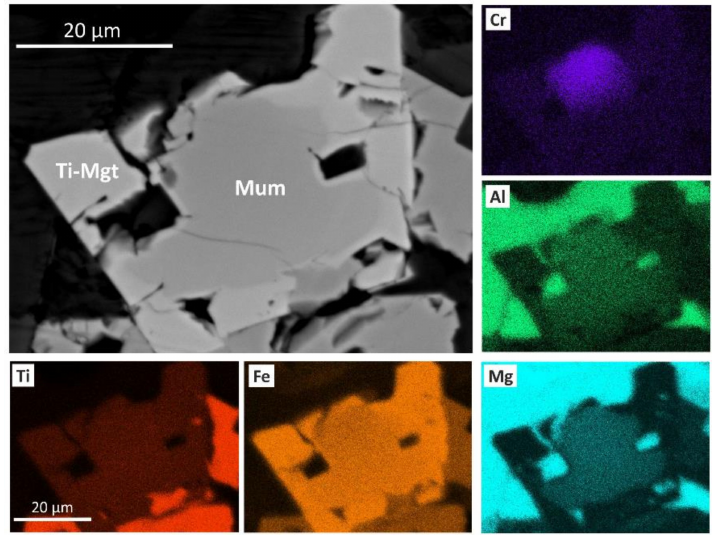
Figure 4. Mum and Ti-magnetite from the aillikites of Terina, BSE images and electron microprobe (EMP) X-ray element maps.